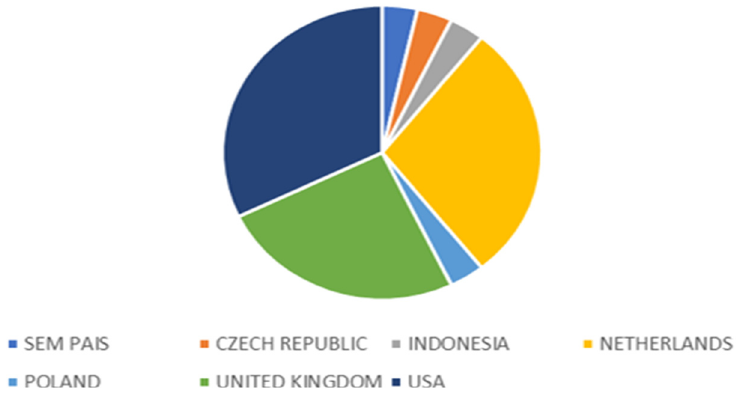
Table 2. Citations per article (n = 31). Figure 6. Countries of the magazines. Figure 6. Countries of the